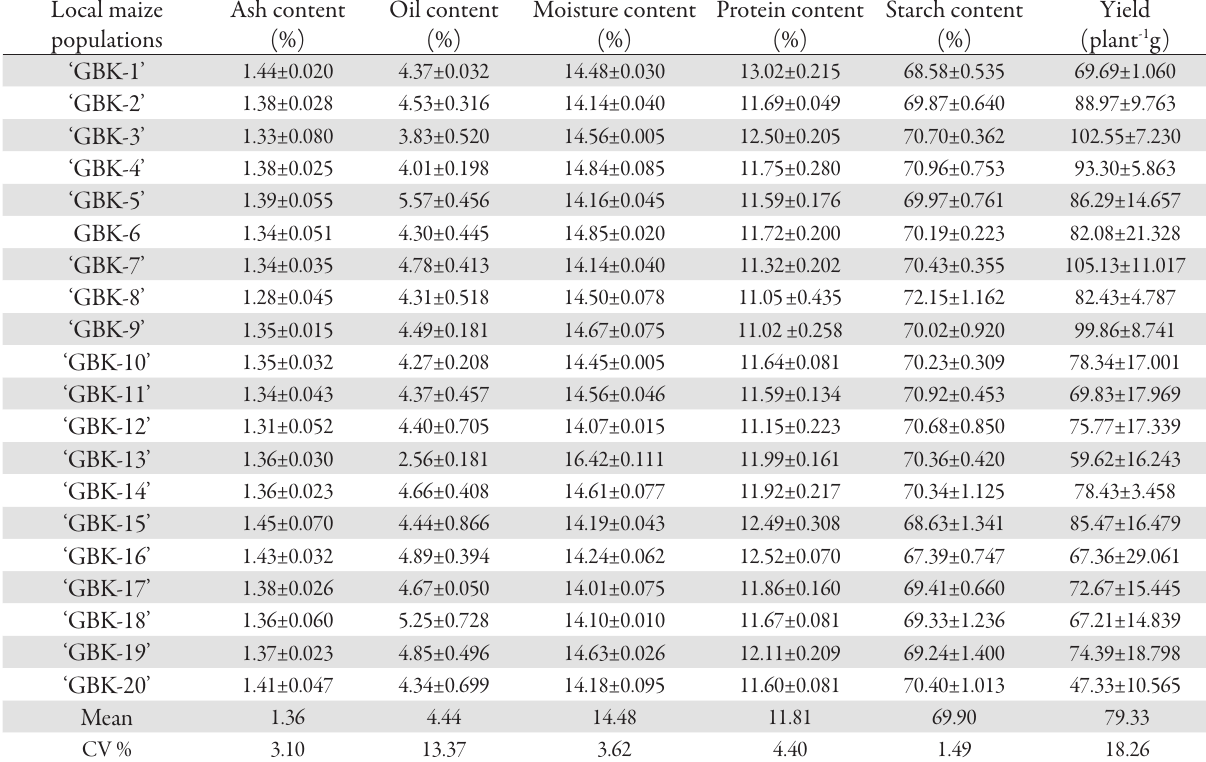
Tab. 3. Means values of grain yield and quality characters in Kosovo local maize populations Local